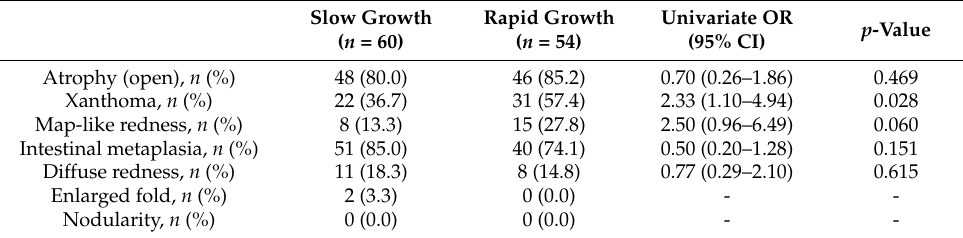
Table 2. Characteristics of endoscopic